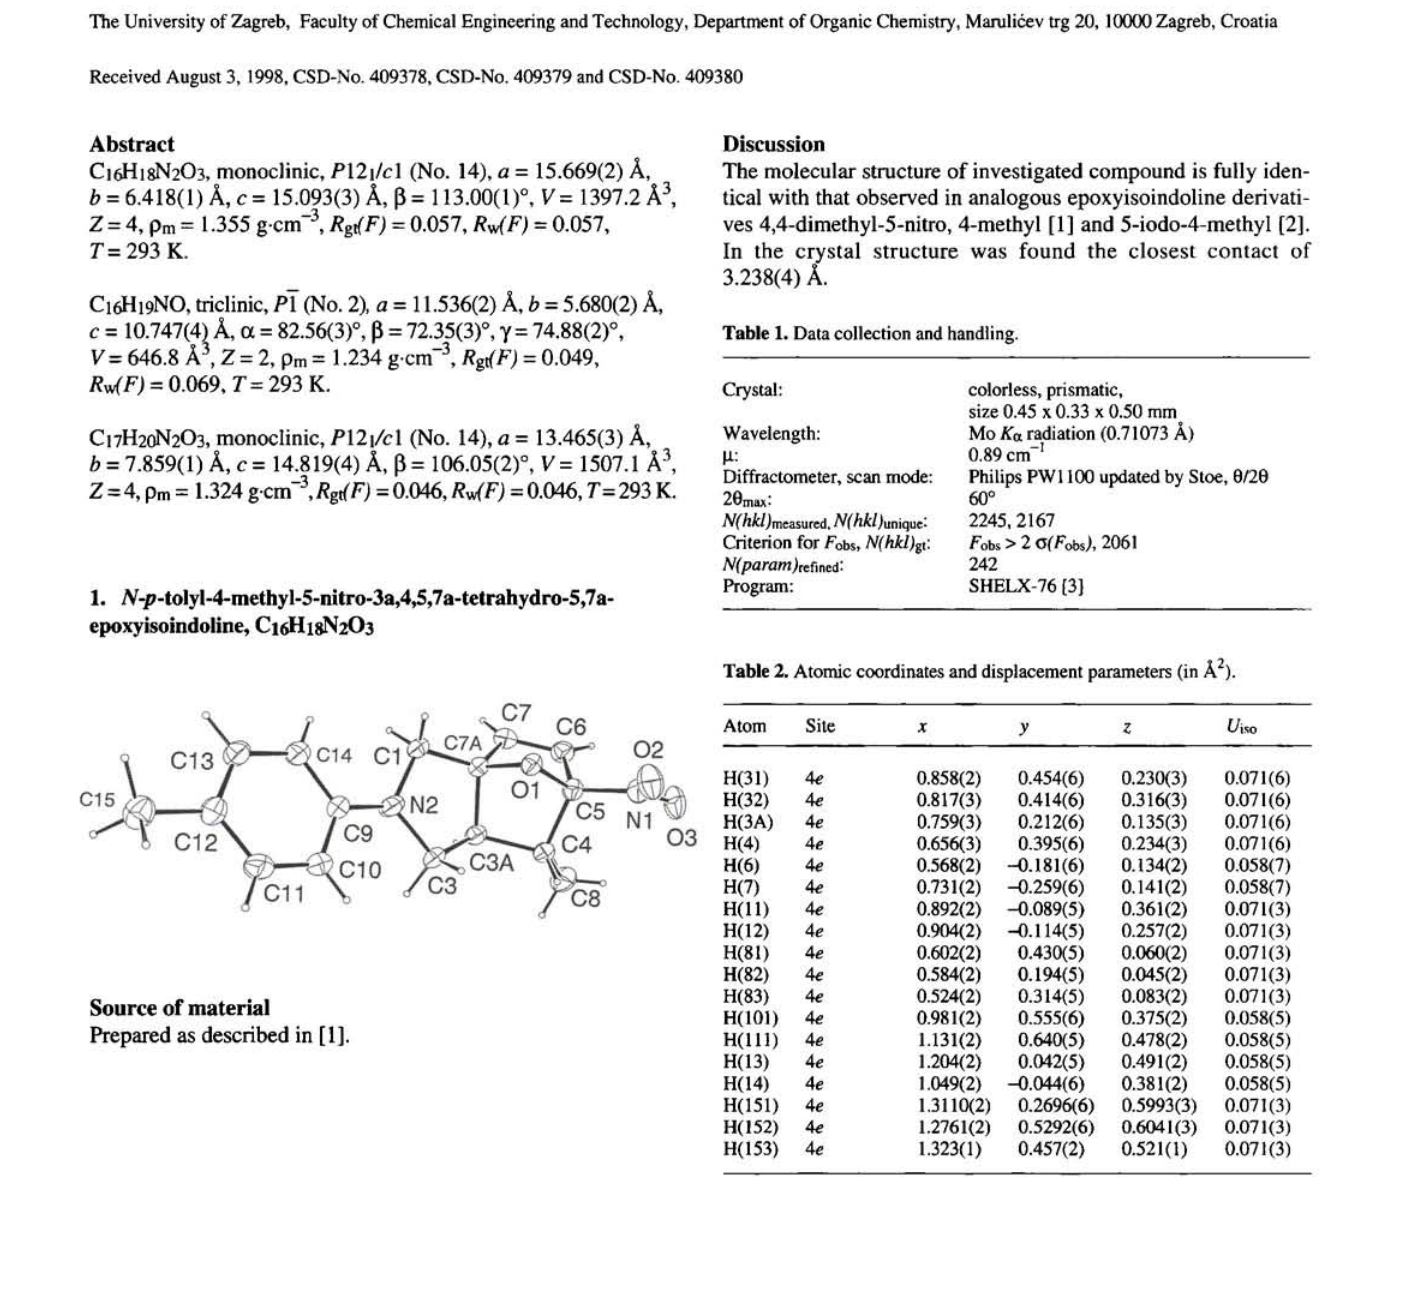
Table 2. Atomic coordinates and displacement parameters (in 1